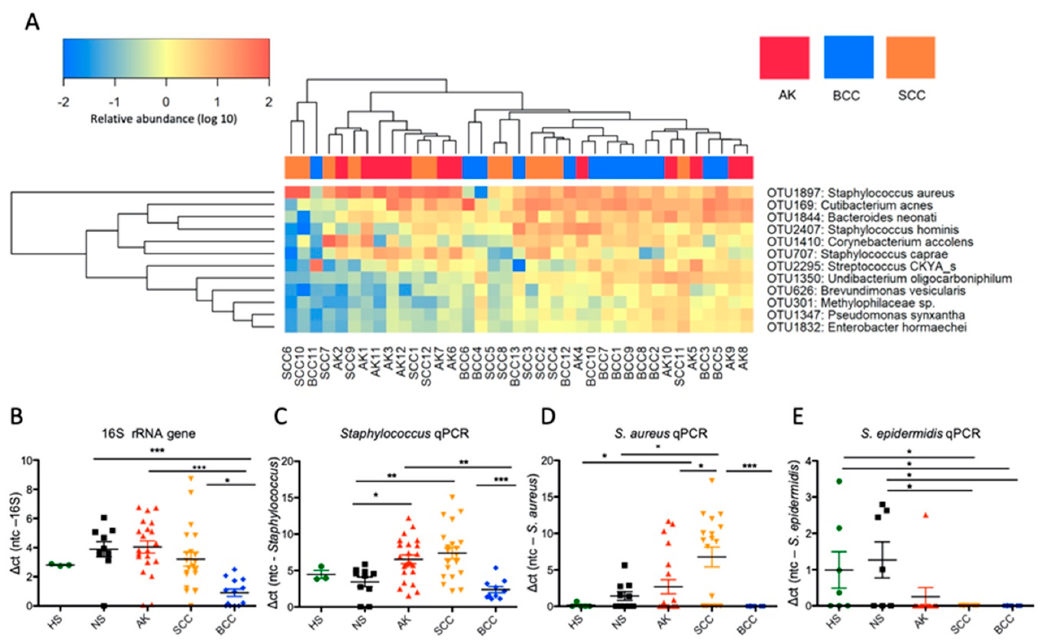
Figure 3. Dominant taxa, bacterial, Staphylococcus and S. aureus loads in keratinocyte skin tumors. ( A ) Heat map representation of dominant taxa revealed by unsupervised hierarchical clustering of log(10)-transformed data indicates a predominant but not exclusive association of S. aureus with AK and SCC samples. Species level taxonomy was assigned by using the EzBioCloud database [15]; see also Figure S5 for a complete heat map representation. Analysis of an expanded sample set by means of qPCR identifies that ( B ) bacterial load (16S rRNA gene) is significantly reduced in BCC, ( C ) Staphylococcus (genus) loads are significantly increased in AK and SCC, and ( D ) S. aureus loads are significantly increased in SCC. ( E ) S. epidermidis loads are significantly reduced in tumors (B and E: Kruskal–Wallis test; Dunn’s multiple comparison test; C and D: ANOVA; Turkey’s multiple comparison test; * p < 0.05; ** p < 0.01; *** p <